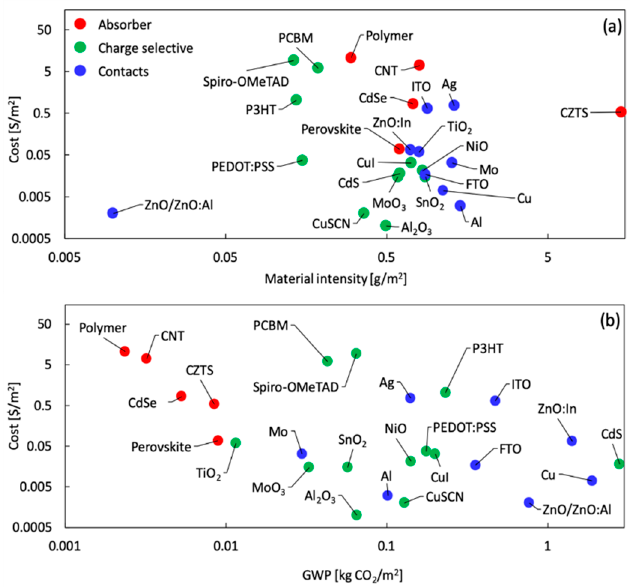
Figure 4. The cost of different PV layers compared to their ( a ) their material intensities and ( b )CO 2 emissions.